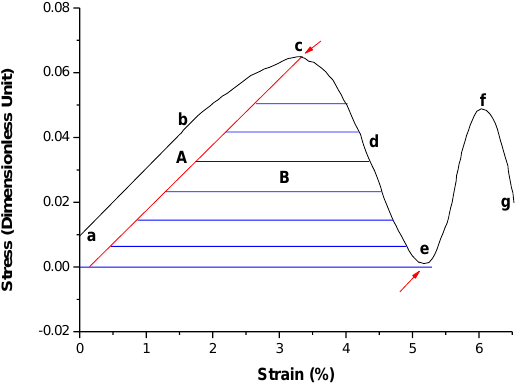
Figure 8. Stress-strain curve of the process of the deformation for the sample by the PFC simulation. The unit of the stress is the dimensionless.